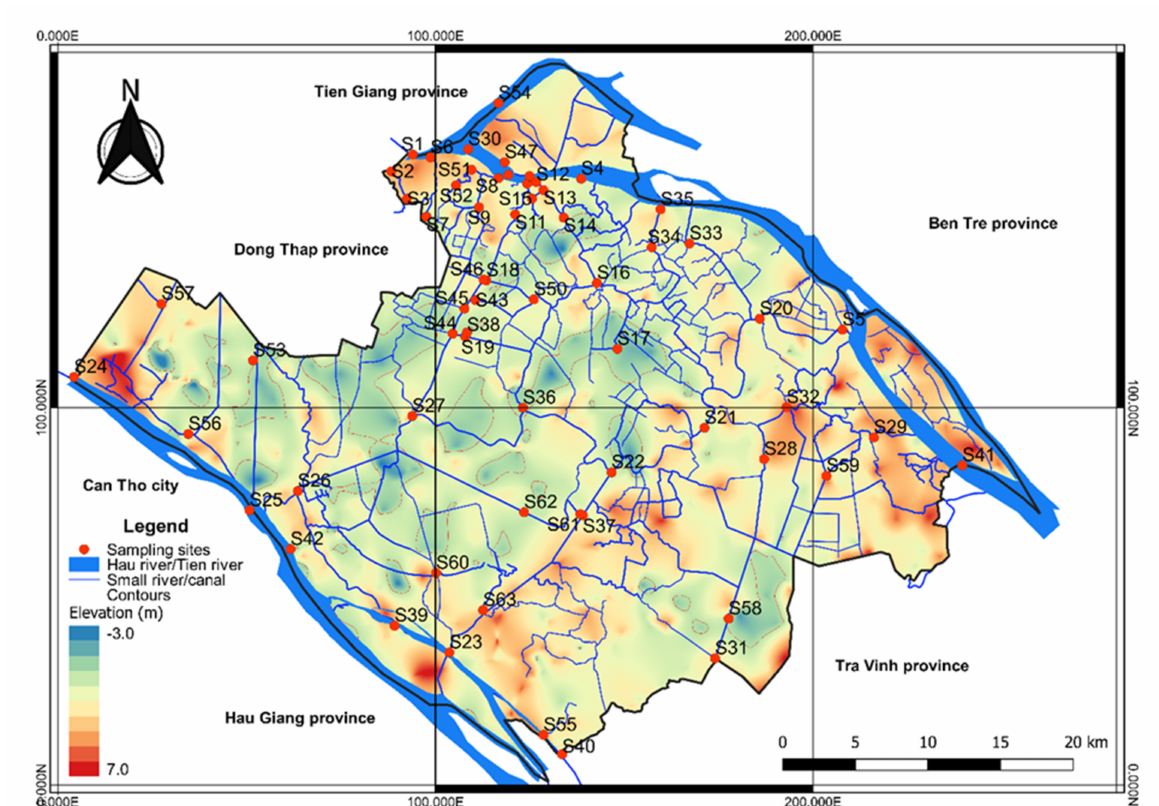
Figure 1. Locations of surface water monitoring in Vinh Long